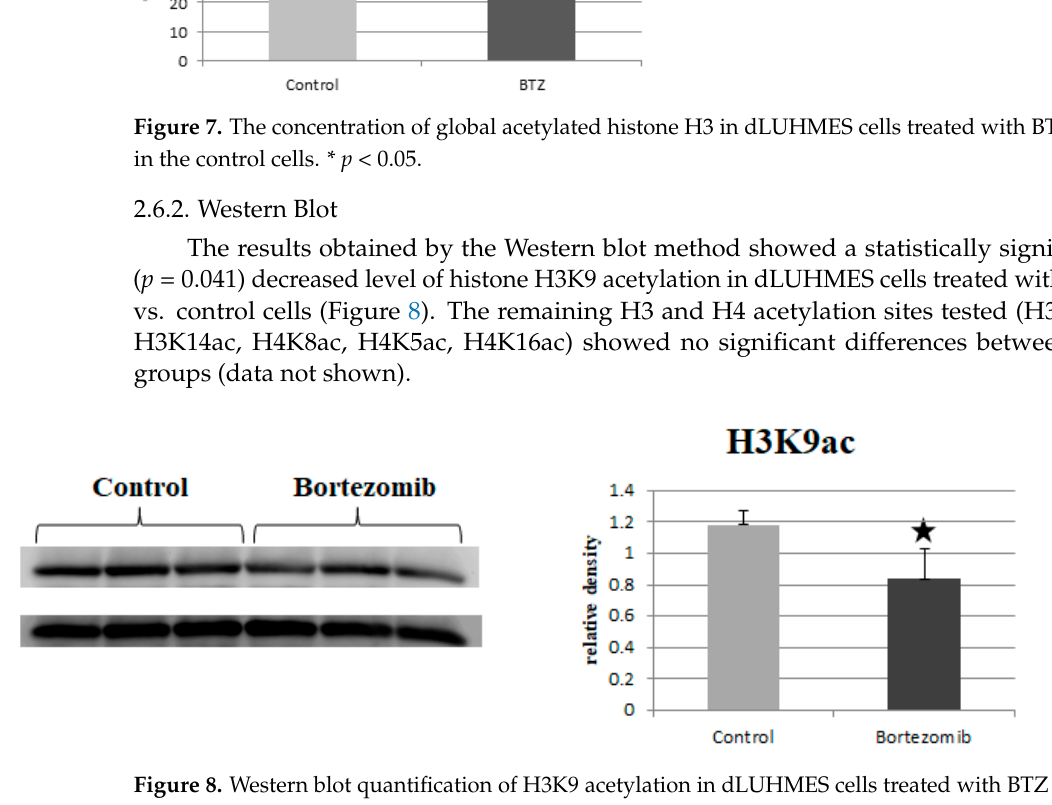
Figure 8. Western blot quantification of H3K9 acetylation in dLUHMES cells treated with BTZ and in the control cells. Data are presented as mean ± SD ( n = 3). * p < 0.05. H3K9ac and H3 bands ob- served at 17 kDa.